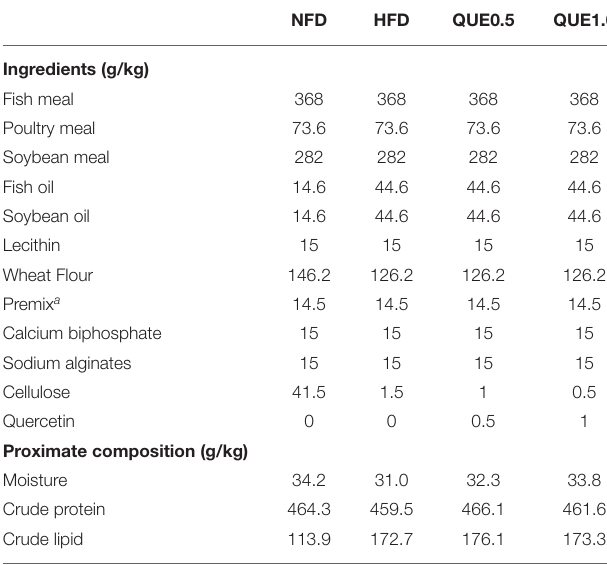
TABLE 1 | Formulation and proximate composition of the experimental diets (g/kg dry